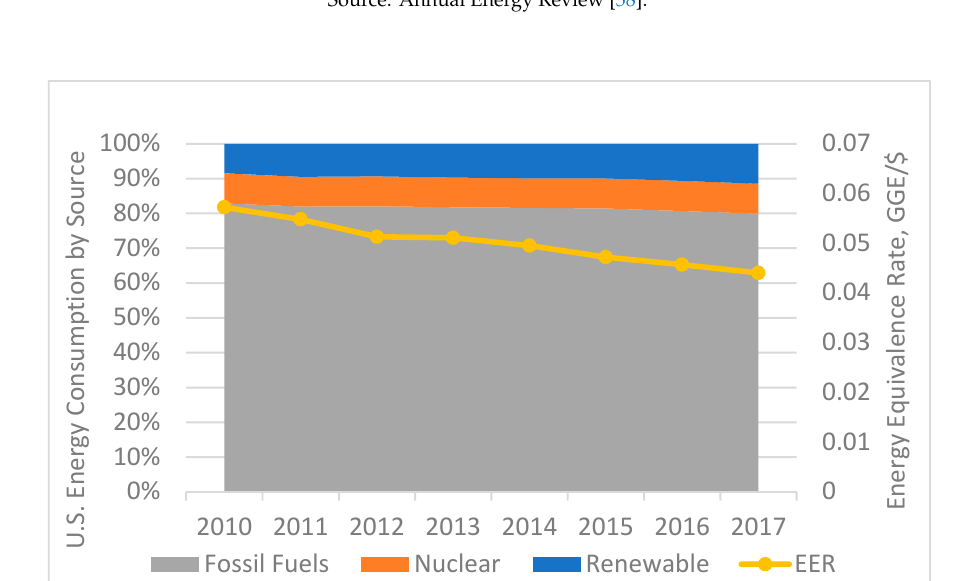
Figure 6. Change of energy equivalence rate (EER).